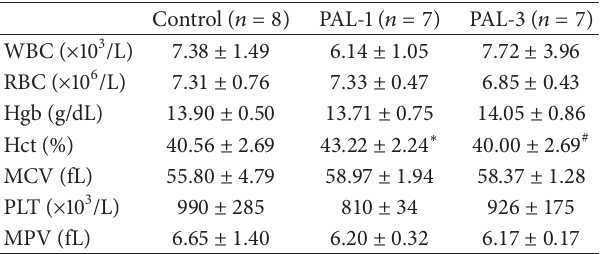
Table 1: The hemogram parameters in control, PAL-1, and PAL-3 groups.